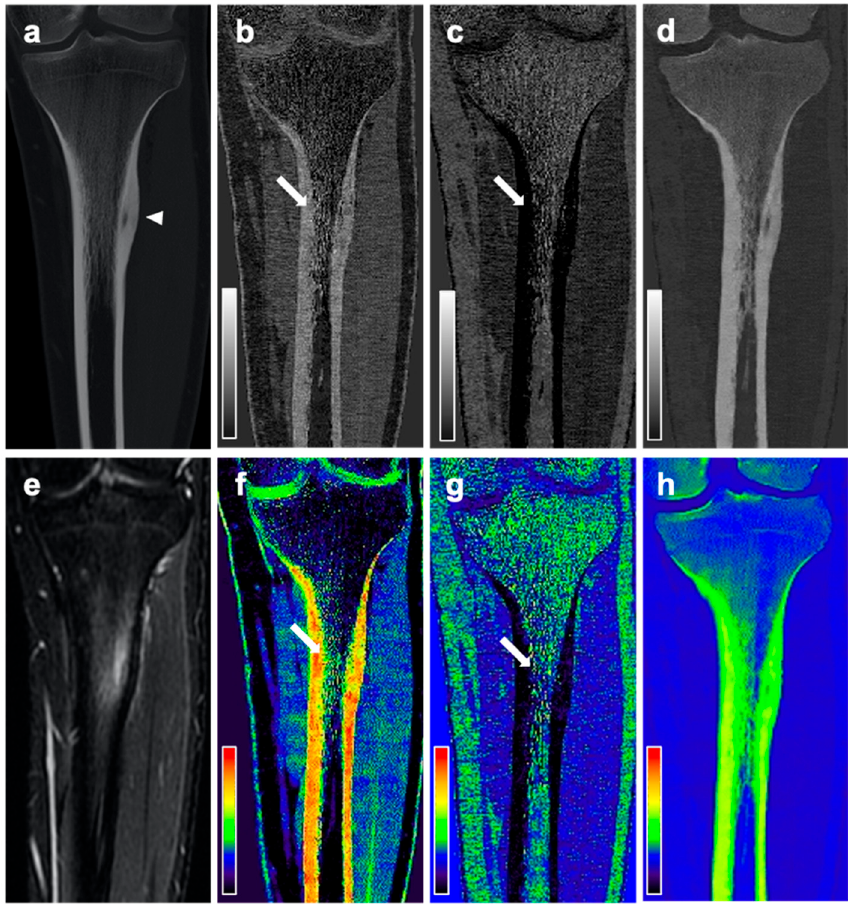
Figure 4. CT and MR images of a 19-year-old male patient with intracortical OO in the left tibia diaphysis. Coronal reformation of the conventional CT examination ( a ) reveals the nidus in the left tibia diaphysis (arrowhead). Material-specific volume fraction maps for red marrow/water ( b ), yellow marrow/fat ( c ), and hydroxyapatite ( d ), and respective color-coded overlays ( f – h ) reveal an increase in water-specific volume fraction in the red-marrow map ( b , f ; arrow) and a decrease in fat-specific volume fraction in the yellow-marrow map ( c , g ; arrow). The corresponding coronal STIR MR image confirms the presence of an edema-equivalent signal alteration in the left tibia diaphysis ( e ).